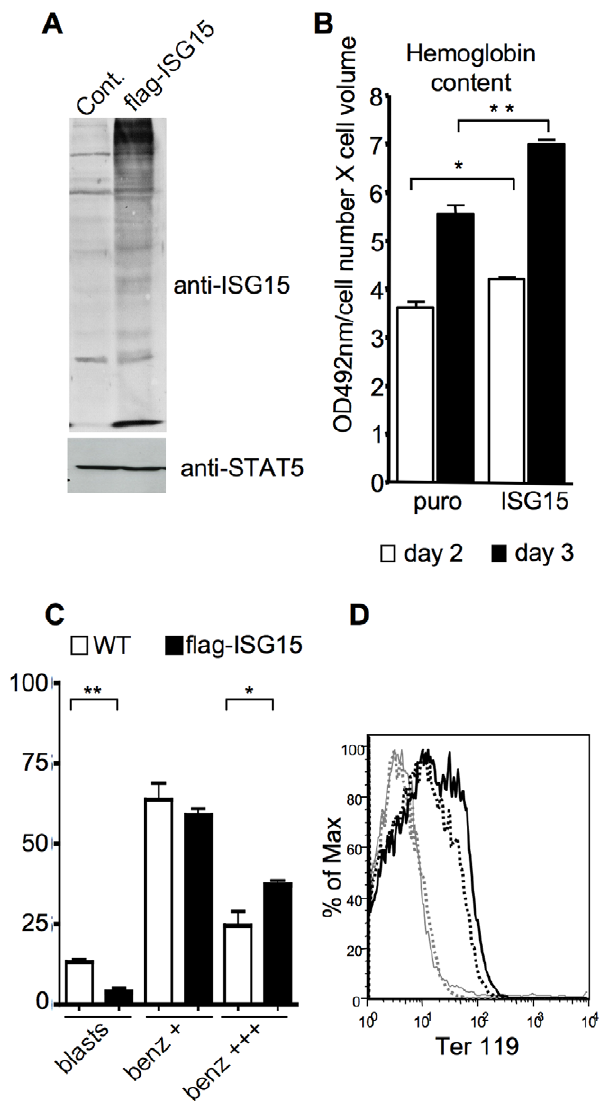
Figure 4. Enforced ISG15 expression facilitates erythroid terminal differentiation. ( A ) Western blot analysis of whole cell extract obtained from proliferating p53 -/- erythroid cell line transduced with either the control MSCV-puro, or MSCV-puro-ISG15-flag retrovi- ruses. An anti-ISG15 antibody was used to show ISG15 expression and induction of protein ISGylation on a 10% acrylamide gel while anti- STAT5 was used as a loading control. ( B ) Hemoglobin content quantification analyses 48 and 72 hours after differentiation induction. ( C ) Quantification of cytospin preparation of 48 h-differentiating control and ISG15-overexpressing erythroblasts. Cells ( $ 200) were counted per slide and mean values 6 s.d. calculated from at least three independent experiments ( D ) Flow cytometry analysis of erythroid cell surface marker Ter119, 72 hours after differentiation induction. Grey line: isotypic control, grey dashed line: control proliferating erythro- blasts (1,34% Ter119 positive cells), black dashed line: control differentiating erythroblasts (24,2% Ter119 positive cells); black line: ISG15-differentiating erythroblasts (34,4% Ter119 positive cells).